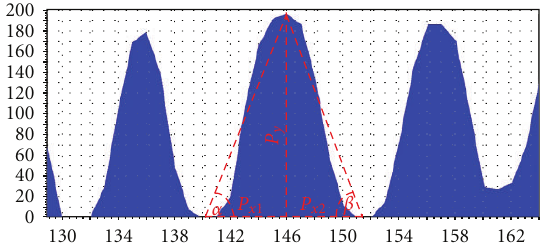
Figure 26: Determination of the upward and downward sections of the curve in a side cut of a papillary line provided by the fingerprint image.